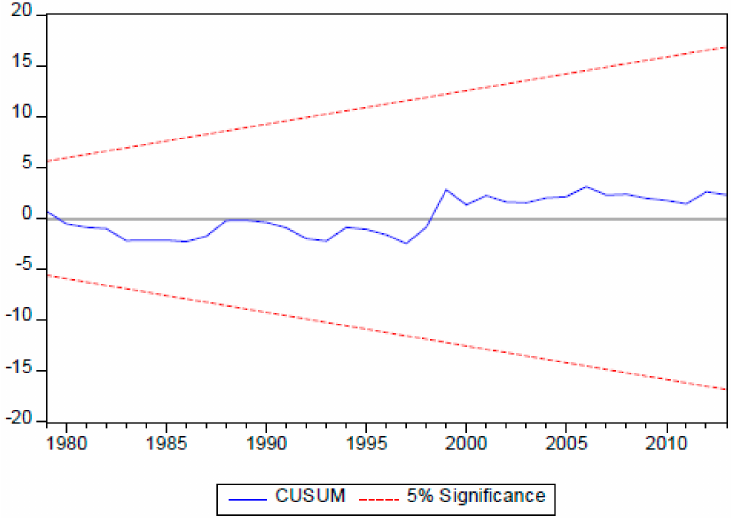
Figure 7. Plot of cumulative sum of recursive residuals for